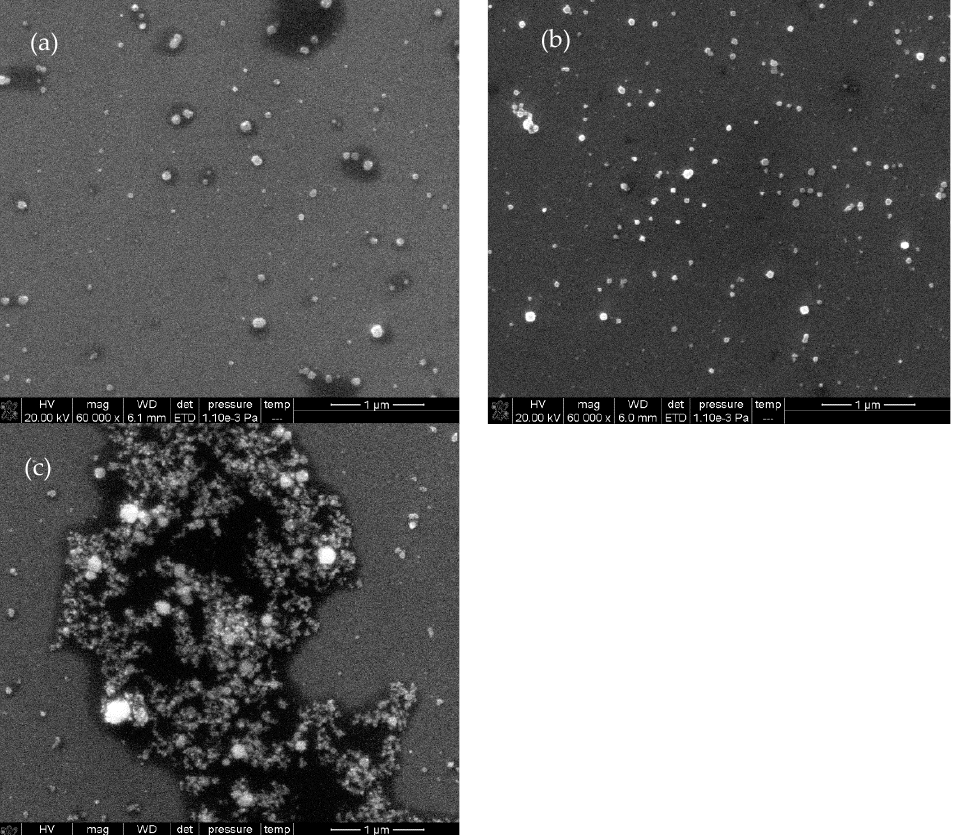
Figure 5. SEM images of Apt–CD-FN3–AgNO 3 –TSC–BPA system (20.67 nmol/L Apt + 333.33 µ g/L CD-FN3 + 1.33 mmol/L AgNO 3 + 4.67 mmol/L TSC) at the temperature of 85 °C for 21 min with different BPA concentrations: ( a ) 0 nmol/L; ( b ) 3.33 nmol/L; ( c ) 13.33 nmol/L.